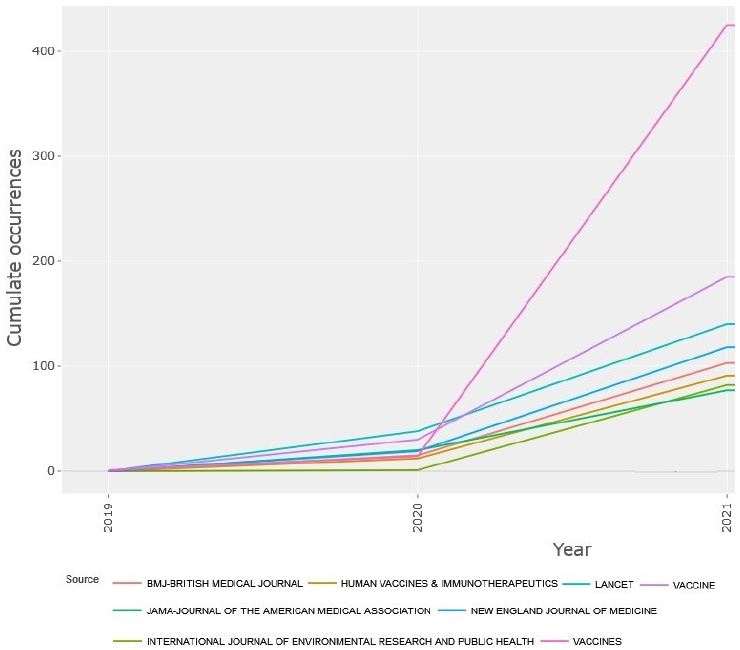
Figure 9. Annual occurrences of the most prolific journals in COVID-19 vaccine research.